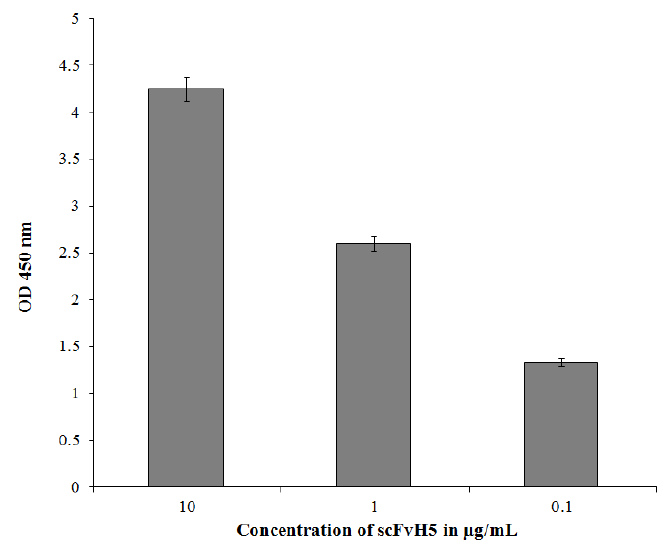
Figure 5. Binding activity of purified scFvH5. Recombinant adiponectin (1 µg) was coated in a microtiter plate. For antigen detection, the purified scFvH5 was serially diluted from 10 µg to 0.1 µg/1 mL. The binding activity of the scFvH5 was detected with protein L-POD. The ELISA results are given as mean ± SD values from triple determinations.